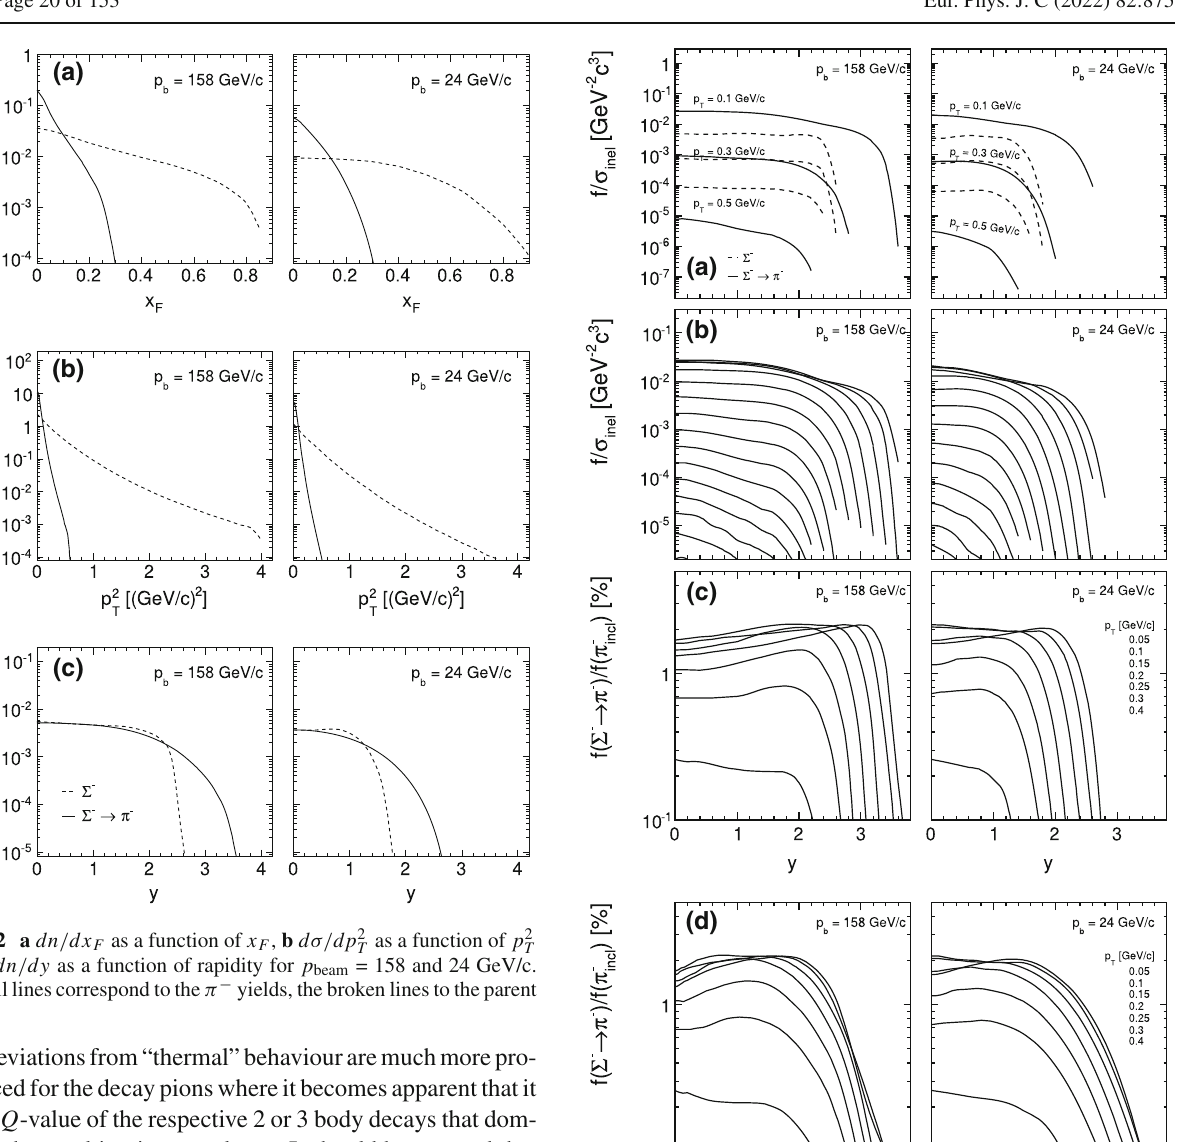
as a function of p 2 T T